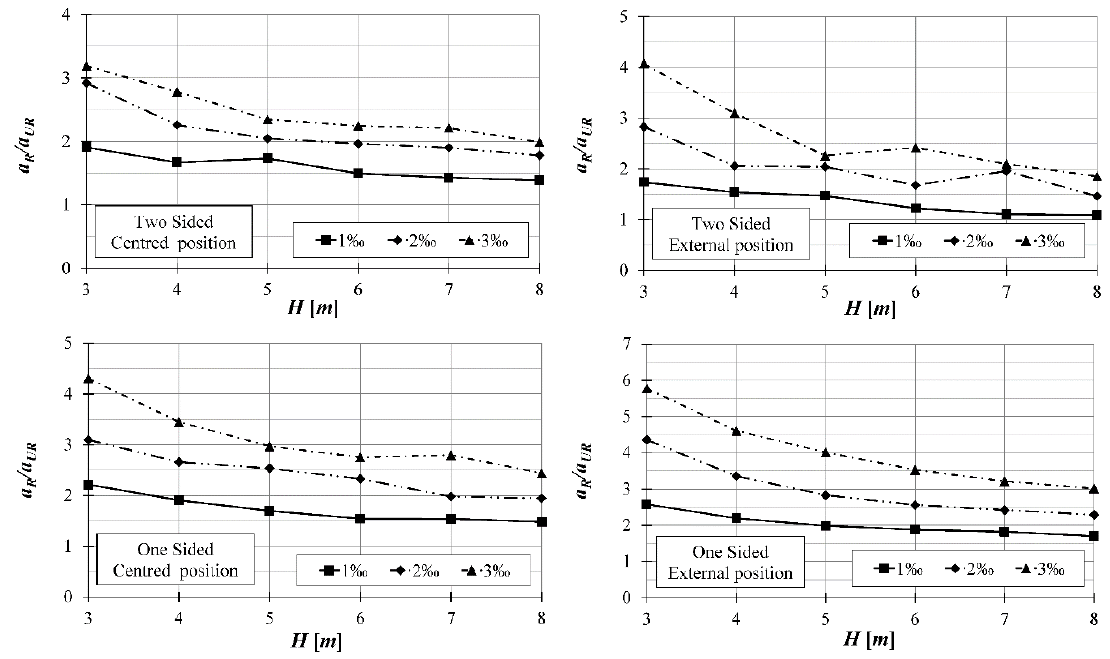
Figure 13. Level of seismic improvement versus height H — α =7.5°, Spectrum A2 , GFRP material.